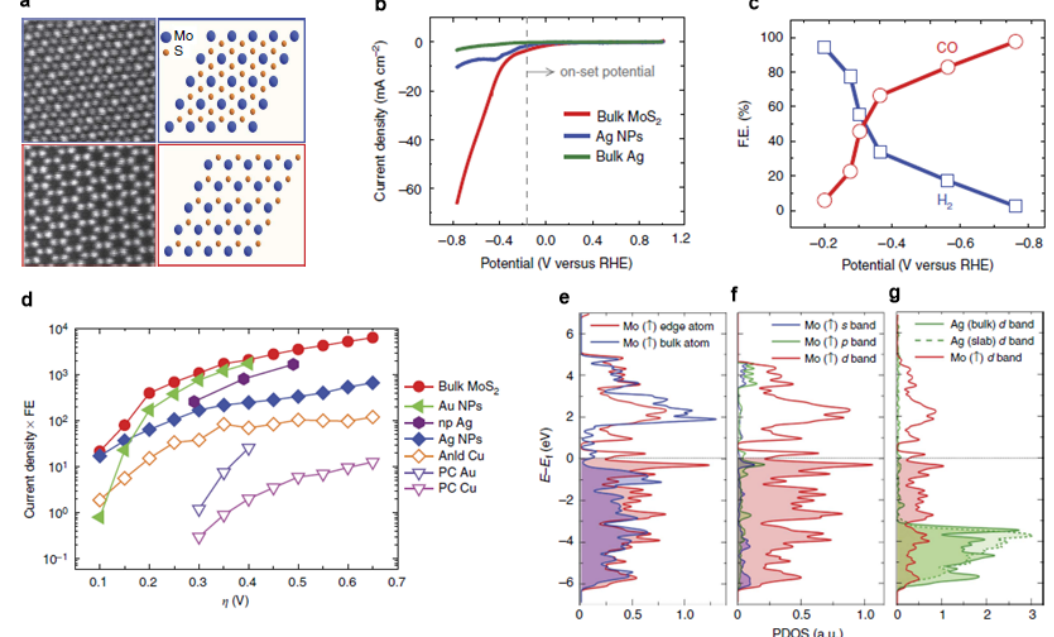
Figure 4. ( a ) High-angle annular dark-field (HAADF) images (scale bar, 5 nm) of the MoS 2 flakes; ( b ) Cyclic voltammogram curves for MoS 2 catalysts; ( c ) CO and H 2 Faradaic efficiency at different applied potentials; ( d ) Overview of different catalysts’ performance at different overpotential; ( e ) The Mo atom at the edge and Mo atom with in the lattice; ( f ) s, p, and d orbital of the Mo-edge atom; ( g ) Projected density of states of d band of the Mo-edge atom, Ag atom from bulk and from a Ag-slab. Adapted with permission from Ref. [42]. Copyright 2014, Nature Publishing Group.